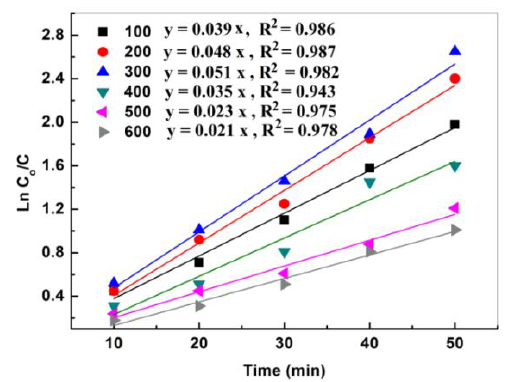
Fig. 7. The plots of relative concentration of methylen blue in logarithmic scale Ln(C /C) vs. irradiation time 0 for the TiO -SiO nanoparticles with different SiO 2 2 content that calcined at 900 o C.